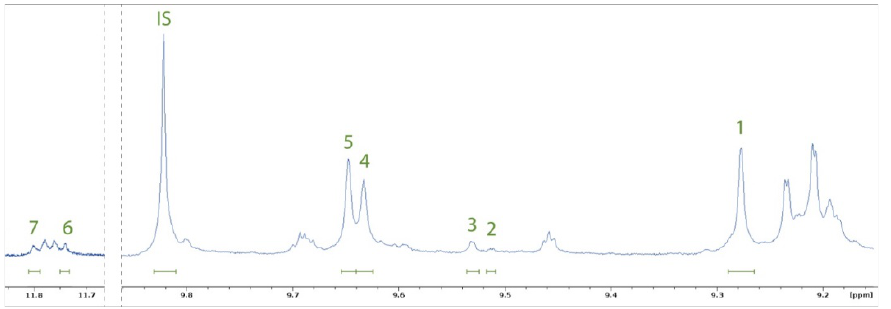
Figure 2. 1 H NMR spectrum of the aldehydic region of EVOO-PEs from the Crnica cultivar. 1—( S )-( E )-elenolide; 2—ligstroside aglycone; 3—oleuropein aglycone; 4—oleocanthal; 5—oleacein; 6—oleokoronal; 7—oleomissional; IS—internal standard (syringaldehyde). Table 2. Phenolic compounds/secoiridoids in EVOOs determined by 1 H qNMR and HPLC. Phenolic Compounds/ Secoiridoids